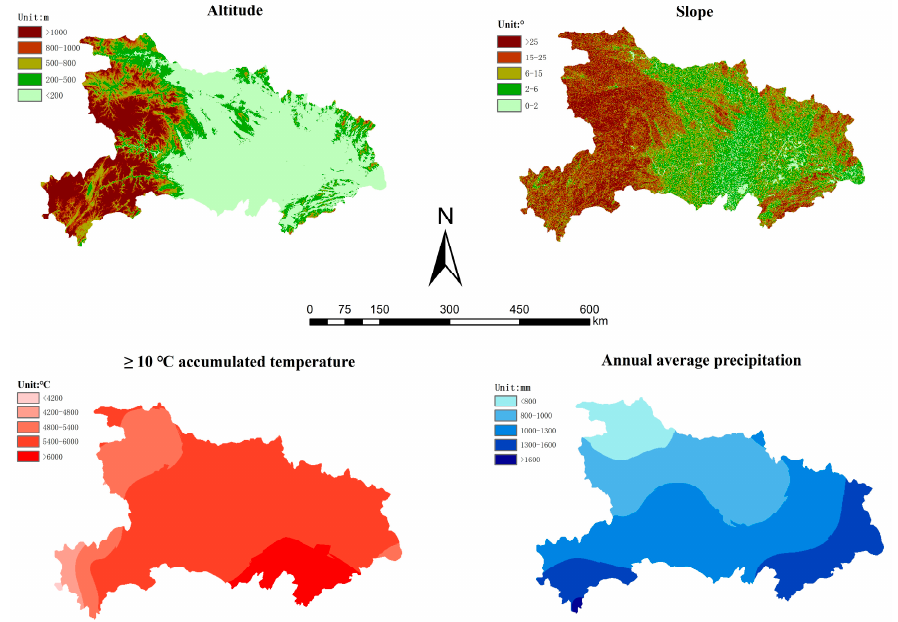
Figure 4. Terrain-Climatic conditions.